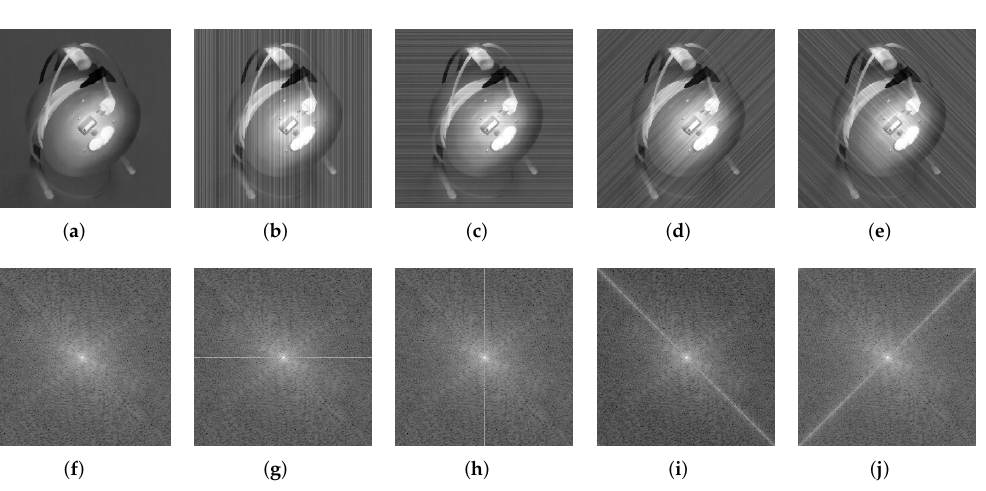
Figure 1. Spectral behavior of stripe noise with different directions. ( a ) Clean image; ( b – e ) Noisy images with vertical, horizontal, right diagonal and left diagonal stripes, respectively; ( f – j ) Amplitude spectrums corresponding to ( a – e